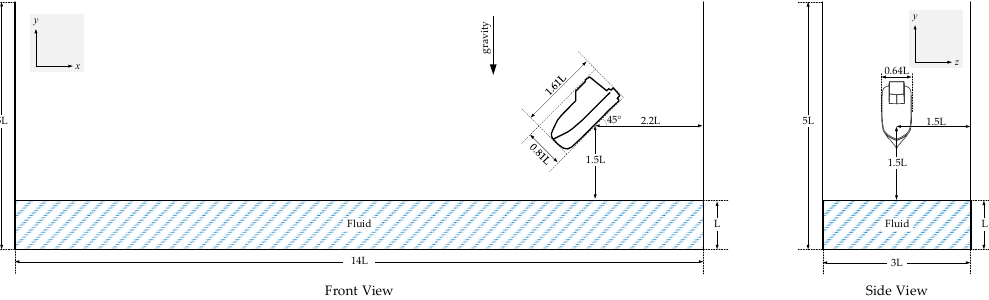
Figure 10. Design drawing of lifeboat entering water scene. The front and side view show the detailed parameters of the bounding box, lifeboat, and ocean. In the experiment, seawater (blue area) fills the